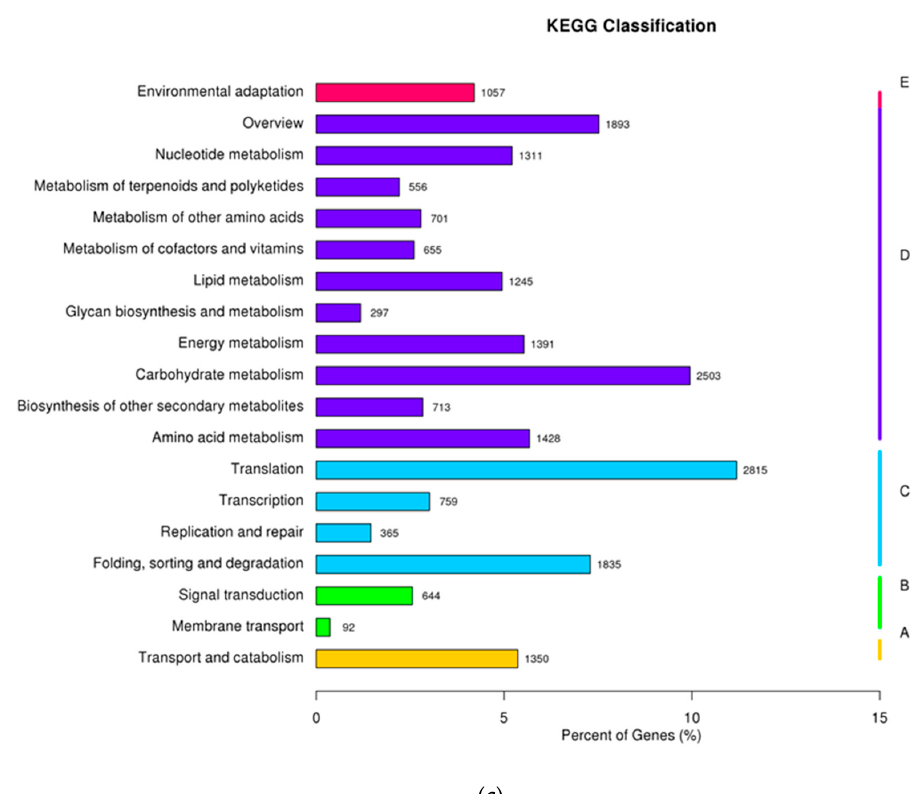
Figure 2. Functional classification of assembled unigenes ( A – C ). Unigene functional predictions based on gene ontology ( A ), euKaryotic orthologous groups ( B ), and Kyoto Encyclopedia of Genes and Genomes ( C ) databases.